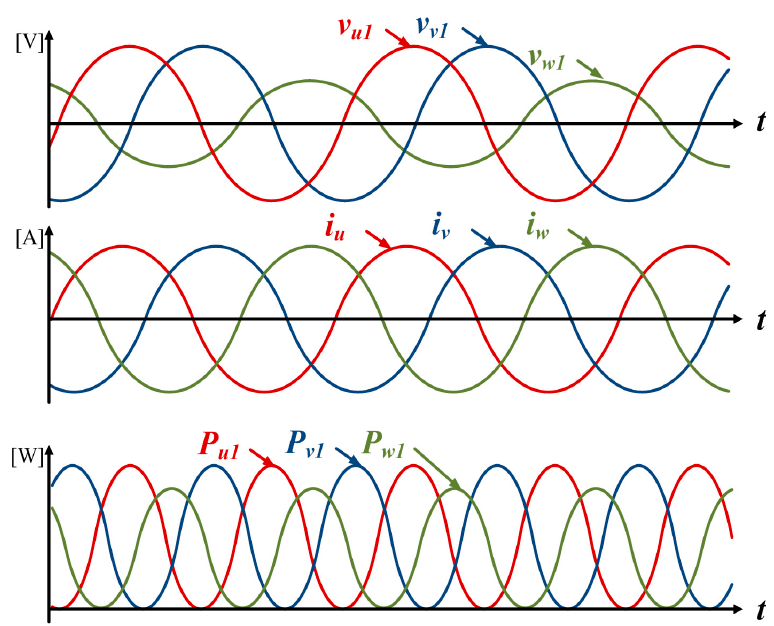
Figure 6. Stack voltage and phase current and stack power of each phase in conventional neutral-point voltage-shifting control.